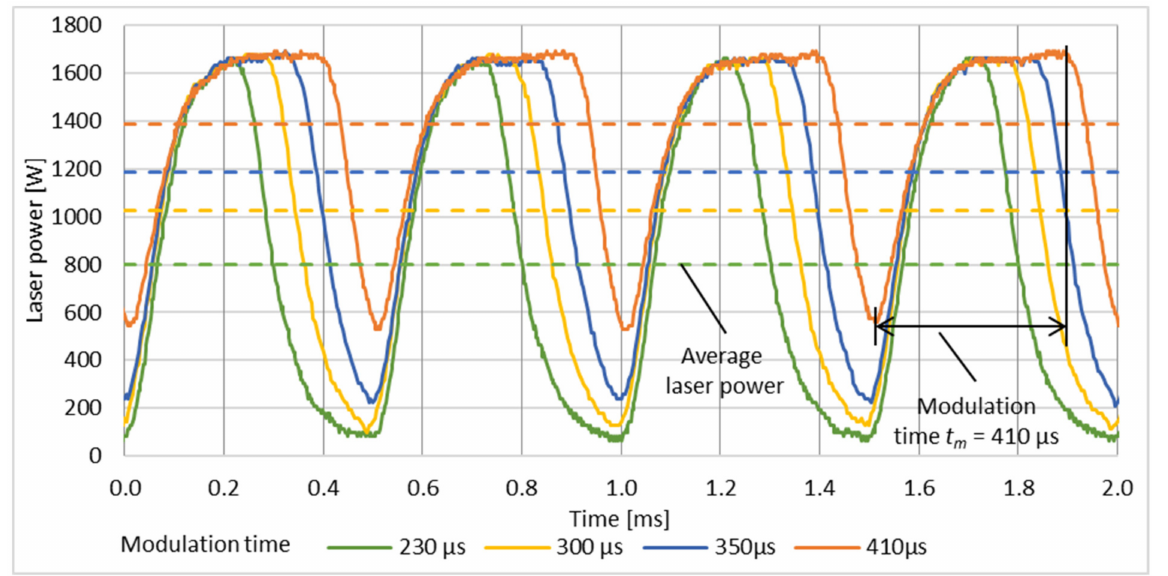
Figure 7. Modulation behaviour at varying modulation time t m at a modulation frequency f m of 2 kHz.